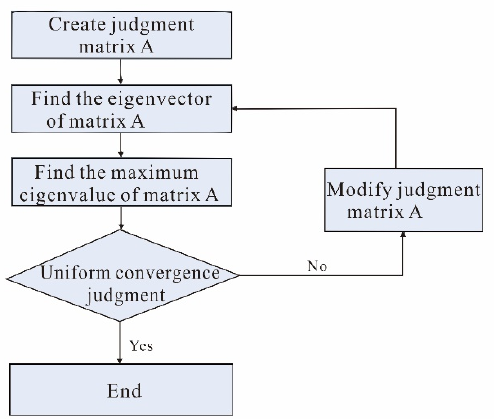
Table 1. Judgment matrix scales and their definitions.